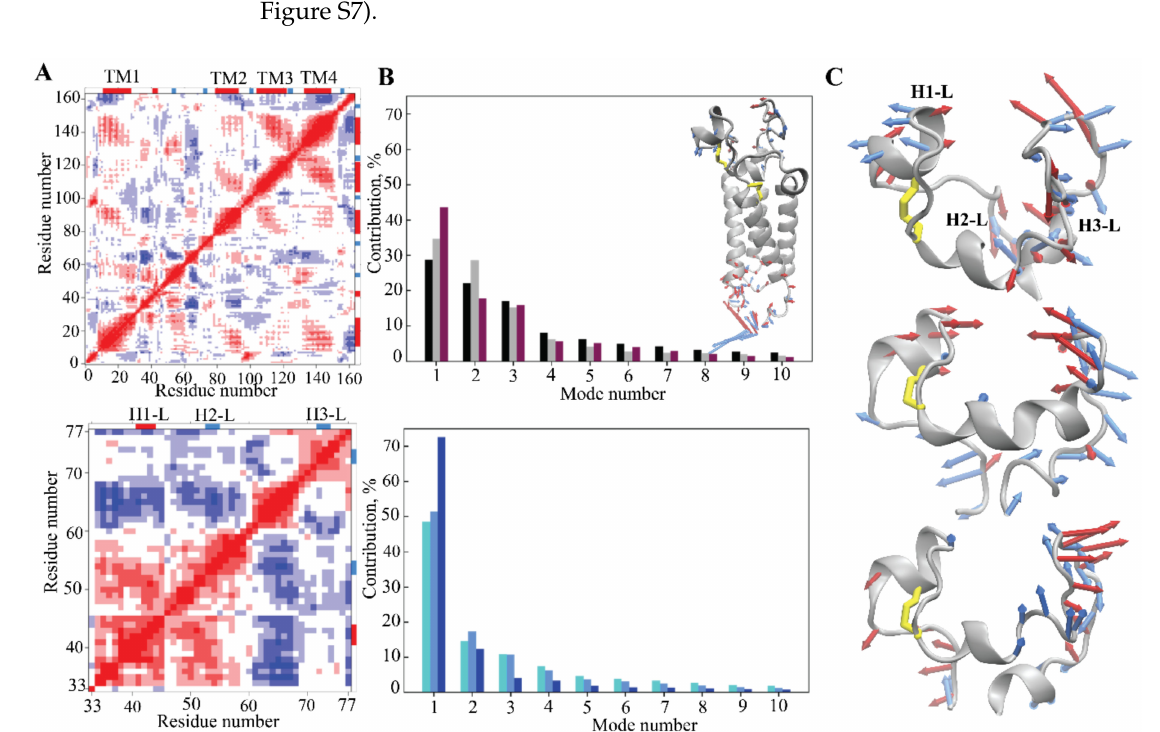
Figure 7. Intrinsic motion of hVKORC1 and its L-loop. ( A ) The inter-residue cross-correlation map computed for the C α -atom pairs after fitting to the respective first conformation ( t = 0 ns) of the full-length hVKORC1 (top) and the L-loop (bottom) is shown for the three replicas. Correlated (positive) and anticorrelated (negative) motions between the C α -atom pairs are shown as a red–blue gradient. ( B ) The PCA modes of the full-length hVKORC1 (top) and the L-loop (bottom), calculated for each MD trajectory after least-square fitting of the MD conformations to the average conformation of the respective domain as a reference. The bar plot gives the eigenvalue spectra in descending order for the first 10 modes. The data for replicas 1 – 3 are coloured black, grey and rose brown, respectively, while, for the full-length hVKORC1, the colouring is clear aqua, blue and navy blue for the L-loop. ( C ) Atomic components in the first PCA modes of the L-loop are drawn as red (1st mode) and blue (2nd mode) arrows projected onto the respective average structure from replicas 1 (top), 2 (middle) and 3 (bottom). Only motion with an amplitude ≥ 2Å is shown. The S-S bridge of hVKORC1 is shown using yellow